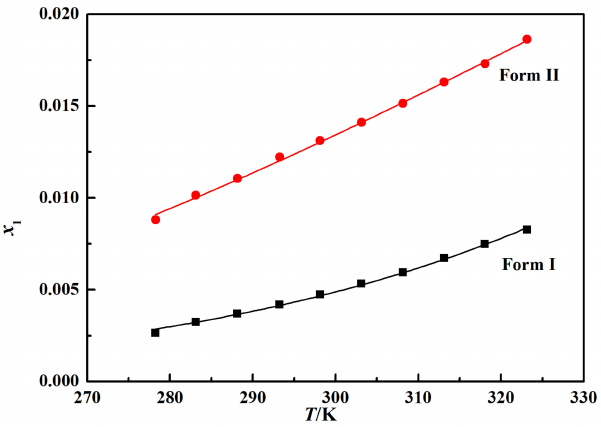
Figure 7. Solubility of L-carnosine form I and form II in a binary solvent mixture of water and